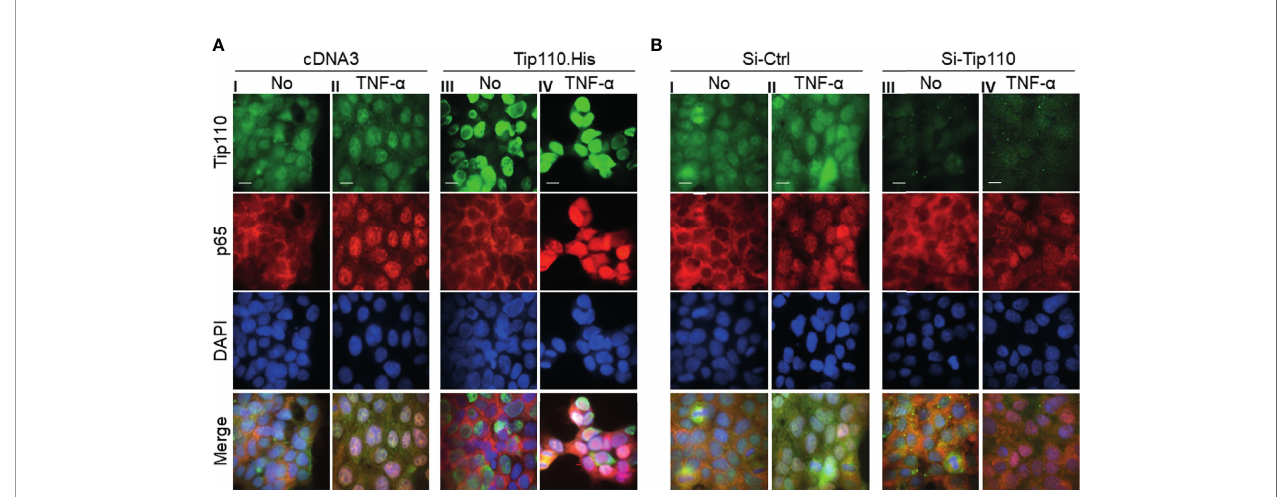
FIGURE 3 | Effects of Tip110 expression and TNF- a treatment on NF- k B p65 nuclear translocation. (A) 293T were transfected with 0.8 µg Tip110.His (A) 50 nM Si- Tip110 (B) , cultured for 24 hr, treated with 20 ng/ml TNF- a for 30 min, and then processed for immunostaining using anti-Tip110 and anti-p65 antibodies. The cells were counterstained with DAPI for nuclei. pcDNA3 or si-Ctrl was used as the respective controls. Representative micrographs were separately taken using fl uorescence microscopy and used to make the composite (Merge). Magni fi cation; 100X, Scale bar,